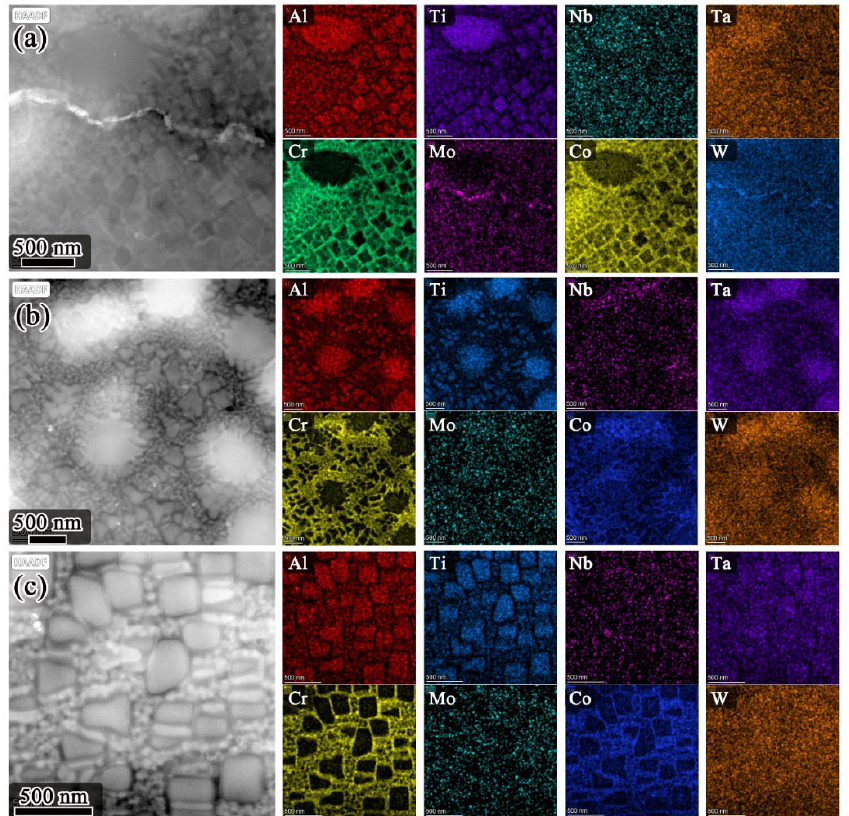
Figure 6. HADDF-STEM images and corresponding EDS mappings showing the elemental distribution in the γ′ phase and γ matrix of FGH4107 solutioned at different temperatures: ( a ) 1160 °C; ( b ) 1180 °C; ( c ) 1200 °C.